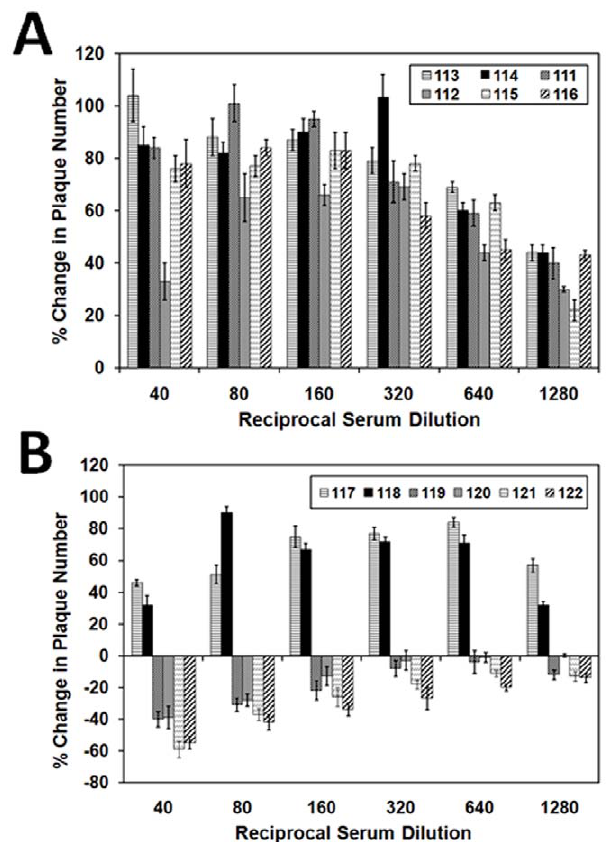
Figure 3. Weak neutralizing activity of vaccinee sera correlates with ADE. Vaccinee sera were selected by their ability to enhance or neutralize of VSV/HCV pseudotype. Sera were serially diluted and incubated for 1h at 37 u C prior to infection of Huh-7.5 cells. Sera with neutralizing titers ( . 1/20) did not exhibit ADE at the dilutions tested.